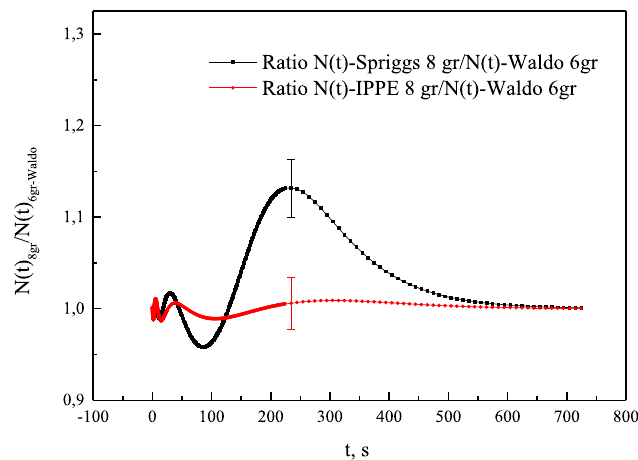
Fig. 1. The ratio of the decay curves calculated on the basis of the 8-group DN dataset with the LANL and the IPPE expansion methods to the DN decay curve obtained with the original 6-group data for 242 Pu by Waldo [8].